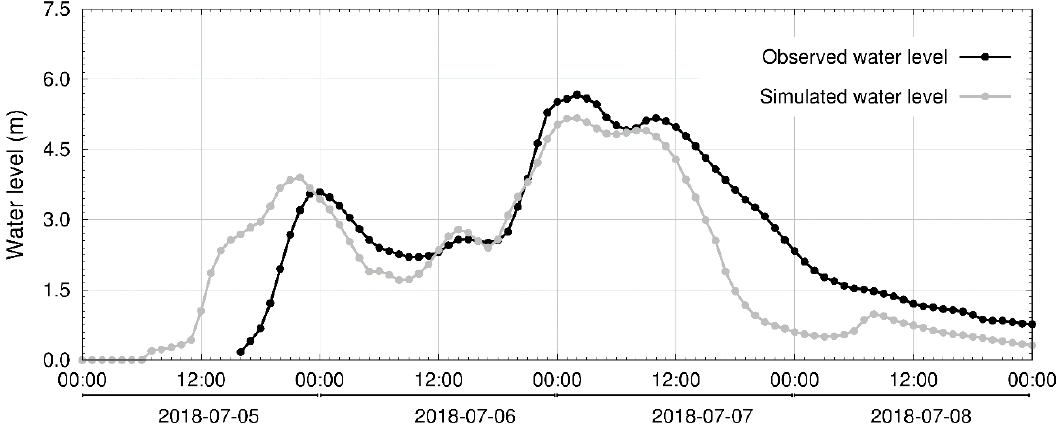
Figure 7. A time series profile of the water level at the Yakage station in the Oda river basin.